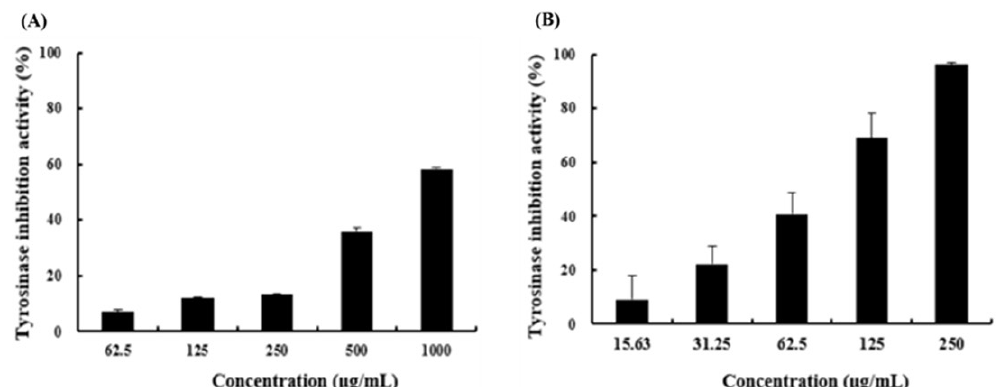
Fig. 2. Tyrosinase inhibition activities of (A) extract of B. subtilis JNUCC and (B) arbutin. The appropriate amount of arbutin was used as a positive control. The inhibition of DOPA Chrome, a reaction product produced by tyrosinase, was confirmed by measuring absorbance. The data are expressed as mean ± SD (n =